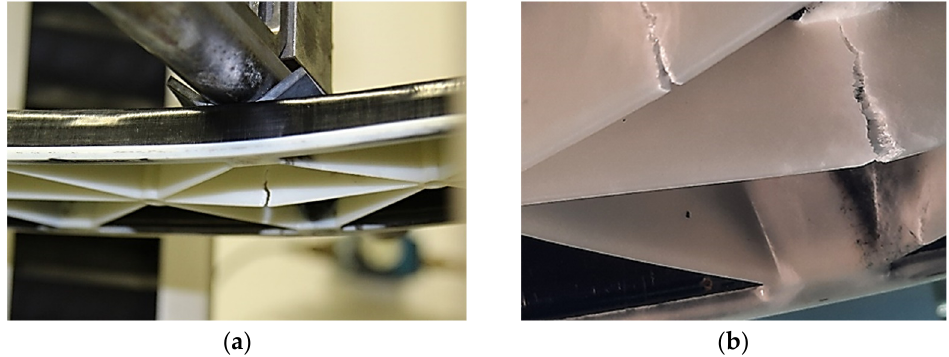
Figure 6. Three-point flexural test of the PP/GF60 and PP/GF30 hybrid injection molded thermo- plastic composite test structure: ( a ) test set-up and ( b ) failure of ribs as a result of the bending load.